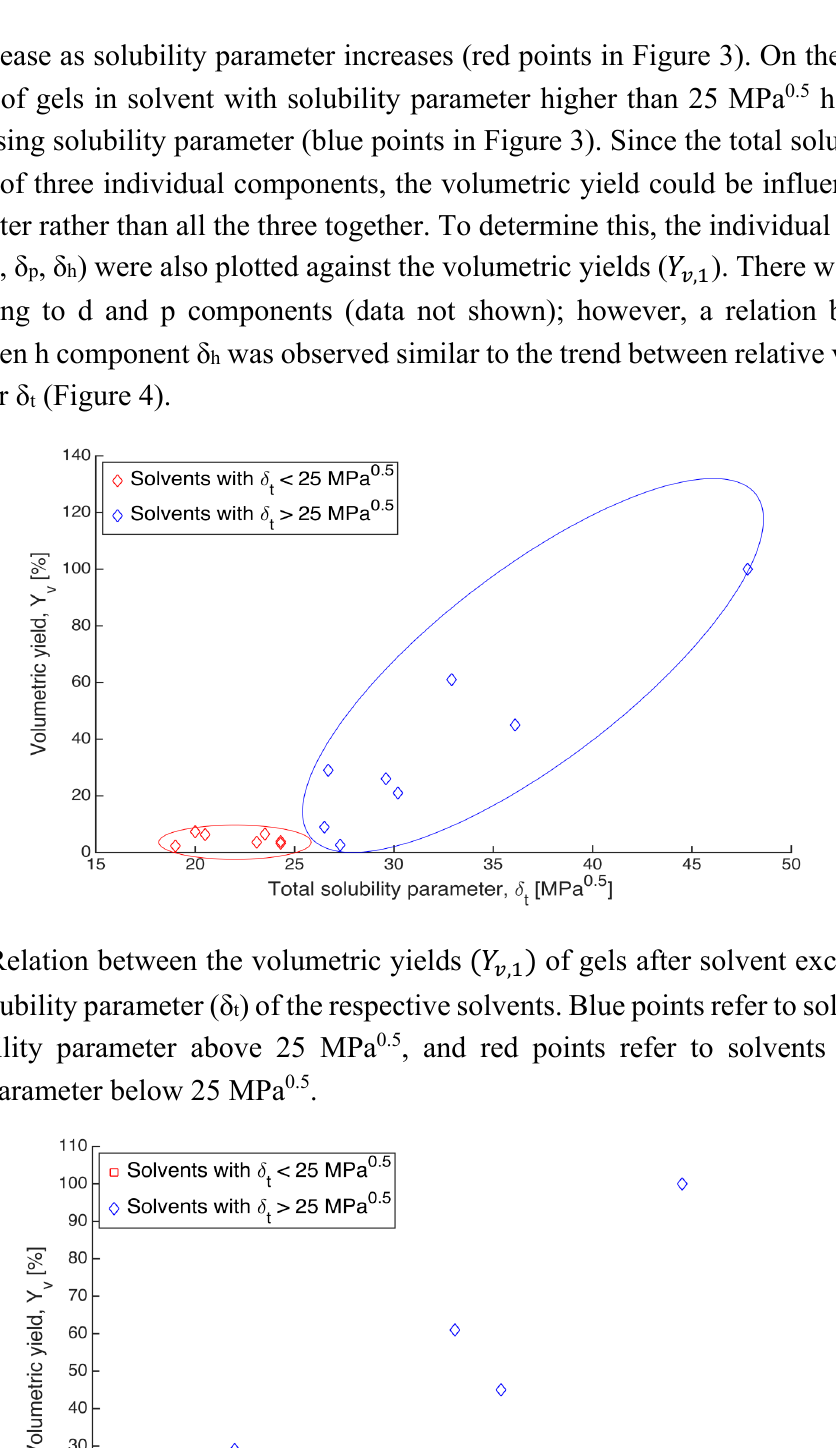
Figure 4. Relation between the volumetric yields ((cid:1851) Hansen h component ( δ h ) of the respective solvents. Blue points refer to solvents with total solubility parameter above 25 MPa 0.5 , and red points refer to solvents with total solubility parameter below 25 MPa 0.5